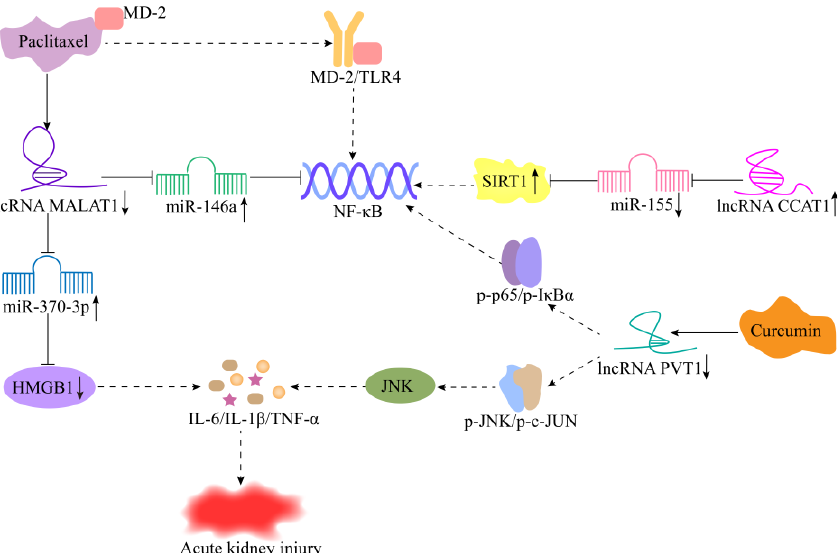
Figure 4. Mechanism of lncRNAs in acute renal injury. LncRNA CCAT1 inhibits the activation of NF- κB via regulating the miR-155/SIRT1 axis. Paclitaxel binds to MD-2 to block MD-2/TLR4 association, resulting in the suppression of NF- κB activation. In addition, paclitaxel can protect against AKI via the regulation of lncRNA MALAT1/miR-370-3p/HMGB1 axis. Knockdown of lncRNA MALAT1 inhibits the activation of NF- κB by targeting miR-146a. Curcumin attenuates the activation of the JNK/NF- κB signaling pathway by inhibiting lncRNA PVT1, thereby alleviating the inflammatory response in AKI.